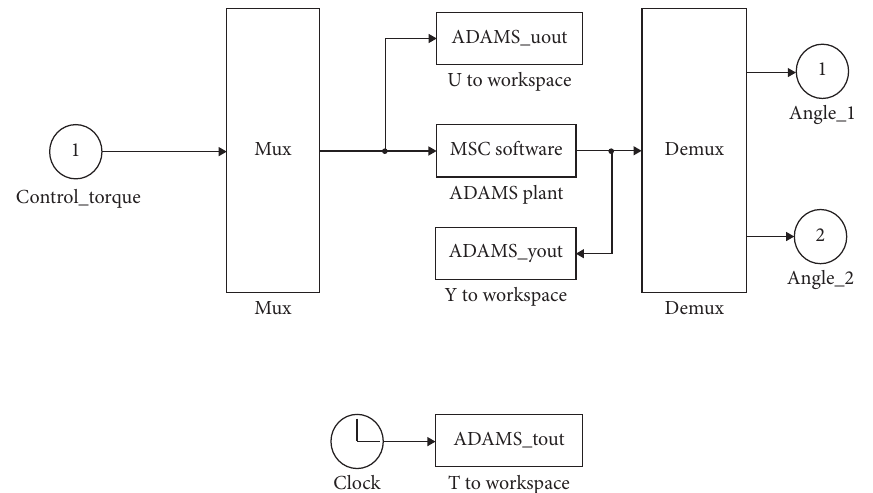
Figure 14: Control plant generated by ADAMS.